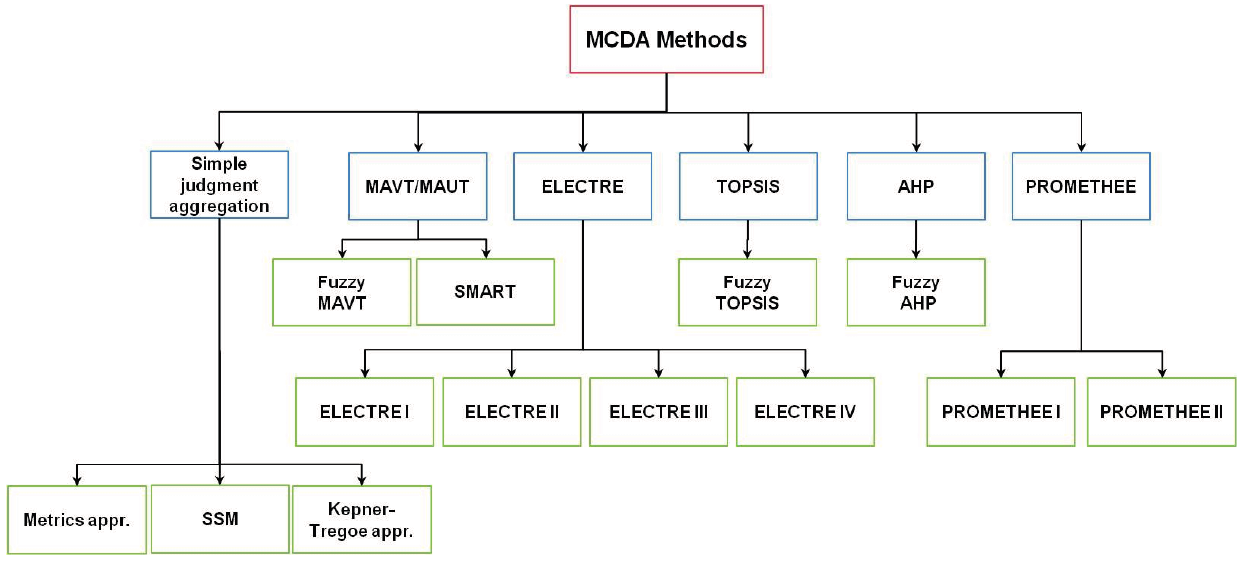
Figure 6. The most commonly used MCDA methods for NESs and NFCs